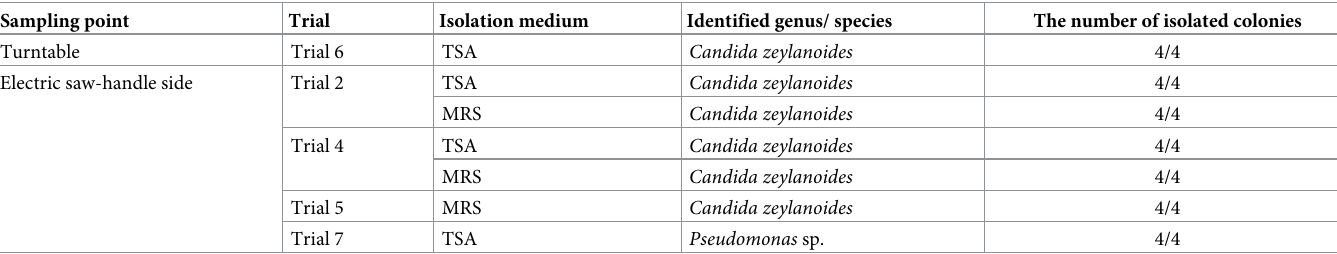
Table 4. Identification results of psychrophilic microorganisms adhering to equipment used in the boning line. Sampling